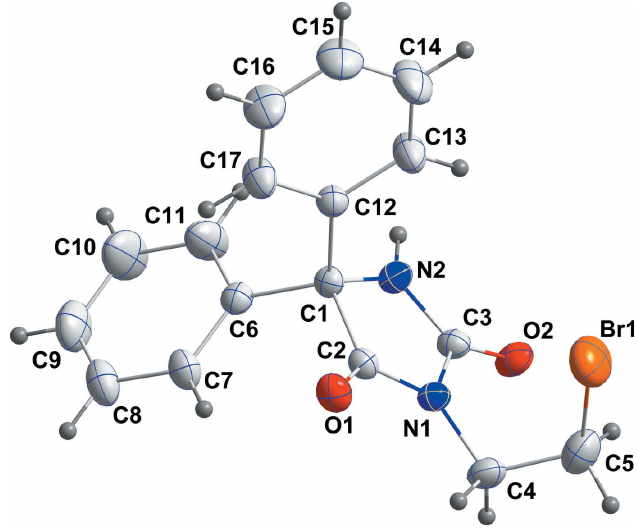
Figure 1 The title molecule showing the atom-labelling scheme and 30% probability ellipsoids.